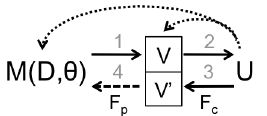
Figure 3. The bi-directional visualization pipeline. Step 1) Create visualization V based on a mathematical model or algorithm M that depends on data D parameters h ; Step 2) display the visualization for users U to assess, Step 4) Users adjust the visualization to offer model feedback; and Step 5) Update the model M (e.g., via the parameters h ).